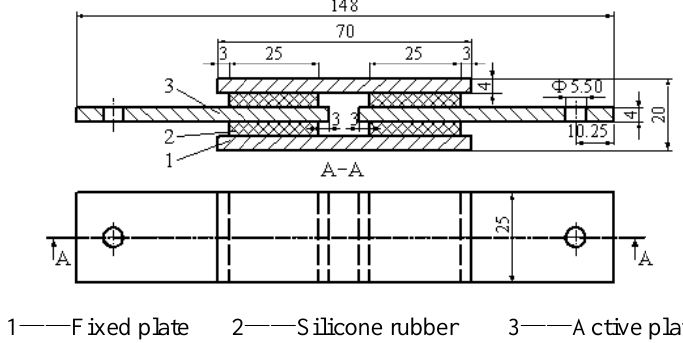
2 —— S ili c on e r ubb e r Figure 3. Four-plate shear specimen. Figure 3. Four-plate shear specimen. Table 1. Material parameters of silicone rubber. Table 1. Material parameters of silicone